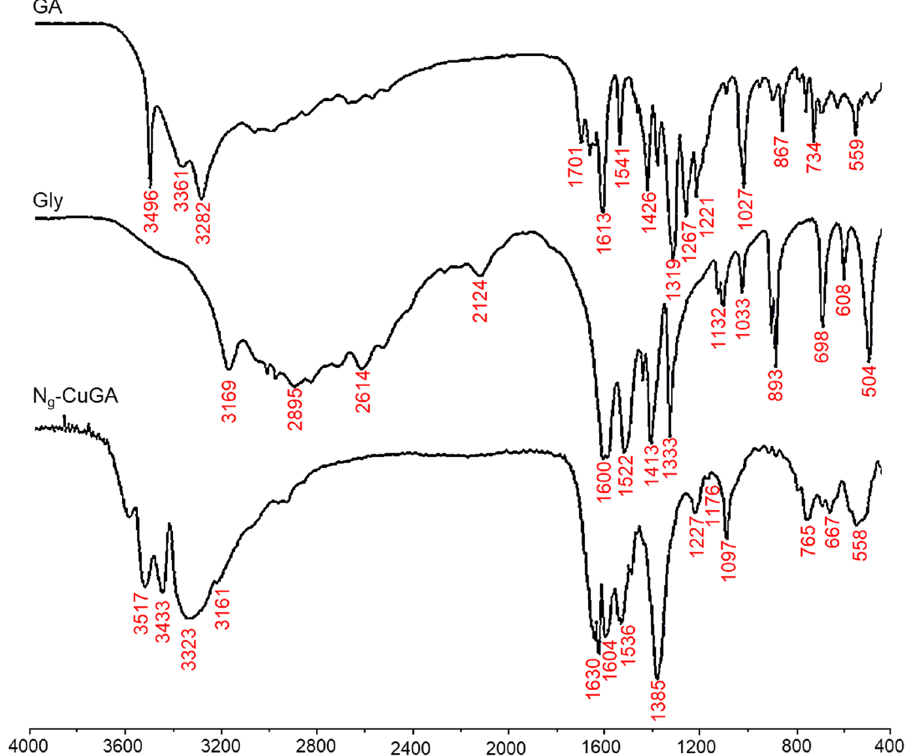
Figure 1. FTIR spectra of N g -CuGA MPN and the parent ligands.